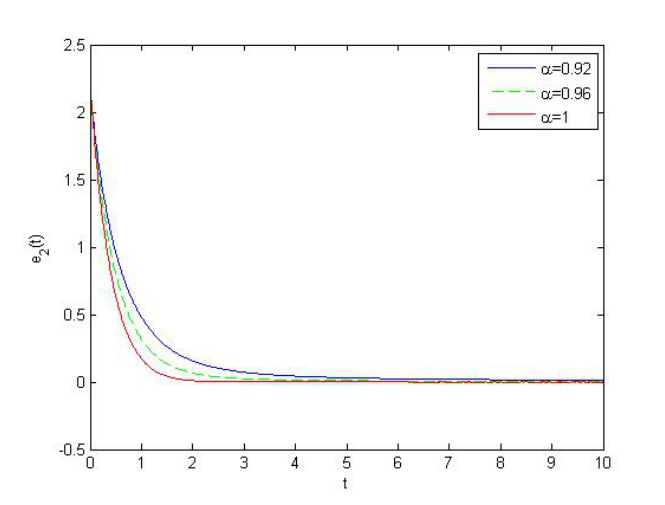
Figure 6. The error state curves between the drive system and response system with different orders q = 0.92, 0.96, 1.